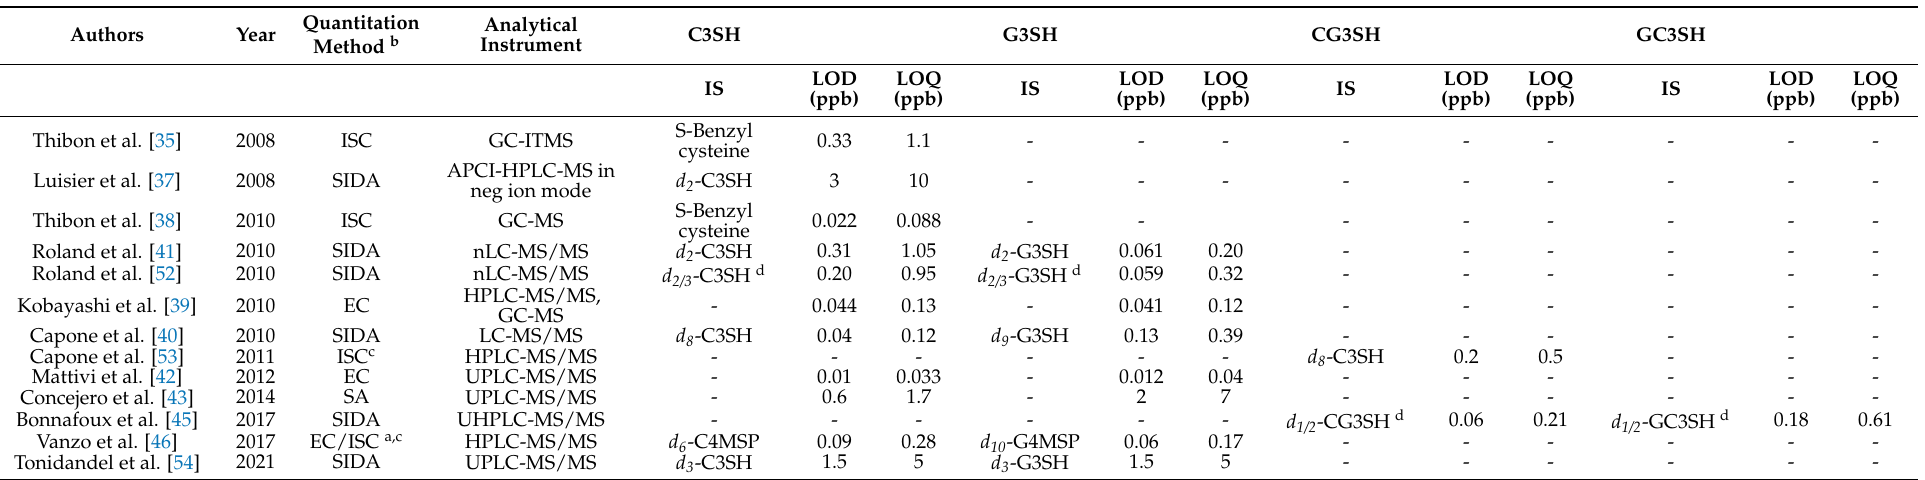
Table 4. A summary of recent quantitative methods for the analysis of 3SH